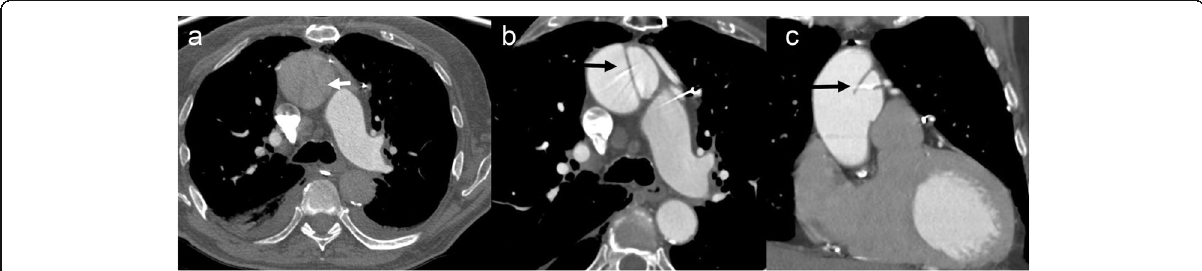
Fig. 8 A 75-year-old man with shortness of breath and chest pain that underwent high-pitch CTA pulmonary artery ( a ) that was negative for pulmonary embolism but a concern for aortic dissection was raised by the cardiovascular radiologist. Aortic protocol CTA confirmed a type A dissection with entry point adjacent to coronary bypass graft (arrow in b and c ) that was very subtle on the CTA pulmonary artery ( a